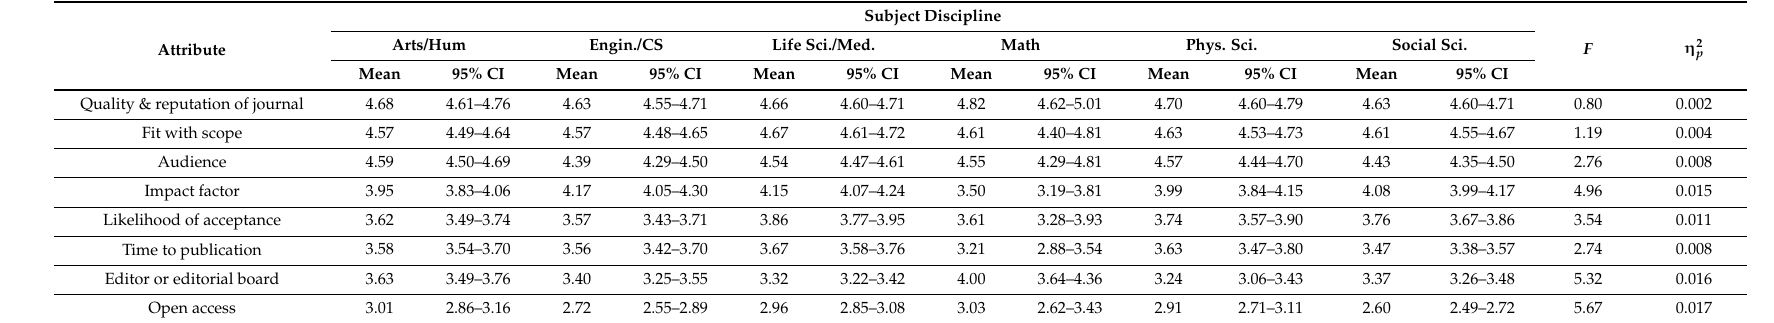
Table 7. Importance of journal attributes by subject discipline.